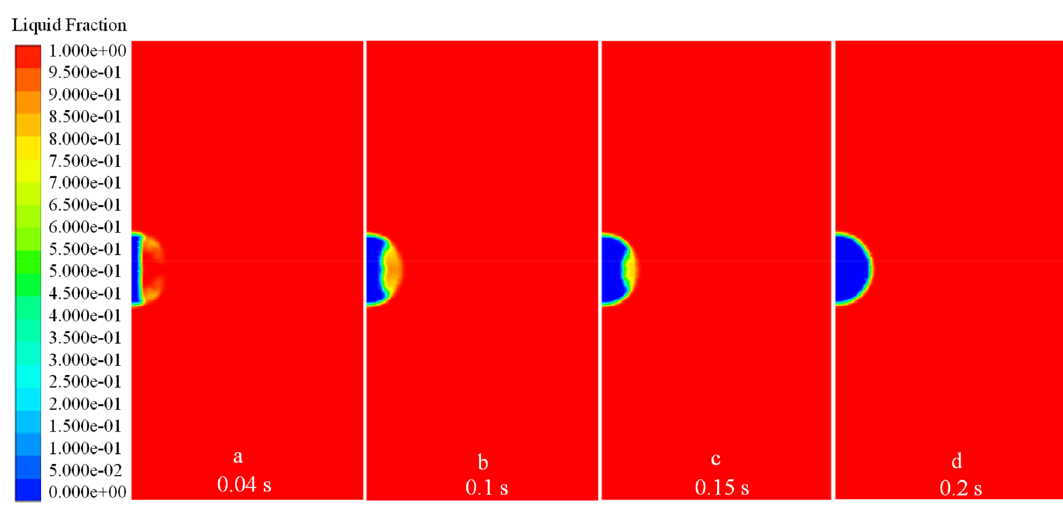
Figure 9. r = 0.5 mm liquid–solid phase volume